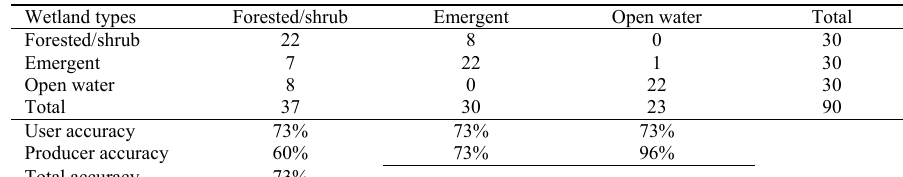
Table 3: Error matrix table of wetland classification Wetland types